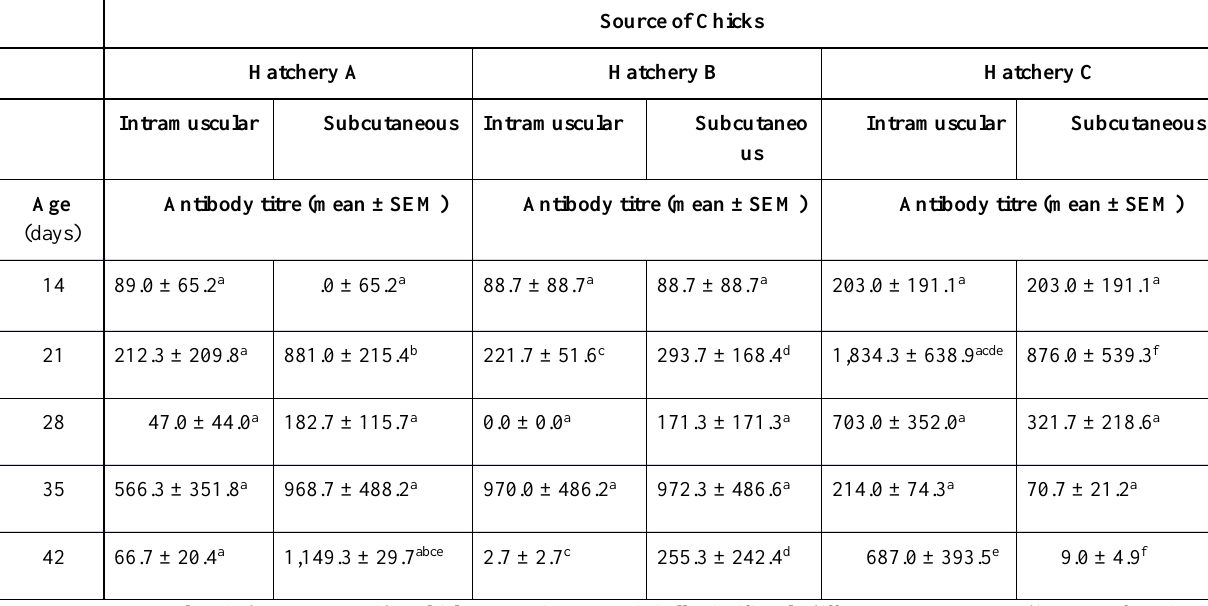
Table 5. Antibody responses of ISA brown pullets from three commercial hatcheries to 0.7 ml dose-regime of inactivated avian influenza H5 vaccine administered at 14 and 28 days of age via either intramuscular or subcutaneous